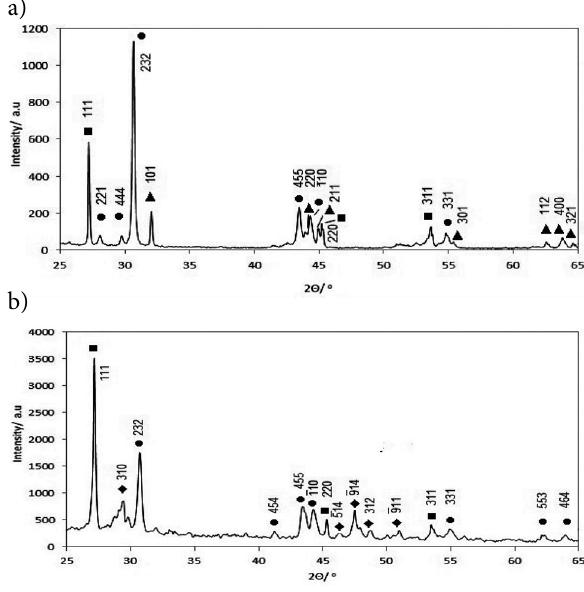
Figure 1. XRD patterns of the alloys of the polythermal section Sn– GeAs: a – 0.33; b – 0.82 mol. f. GeAs. The symbols denote:  – Sn 4 As 3 ;  – Ge;  – Sn;  –